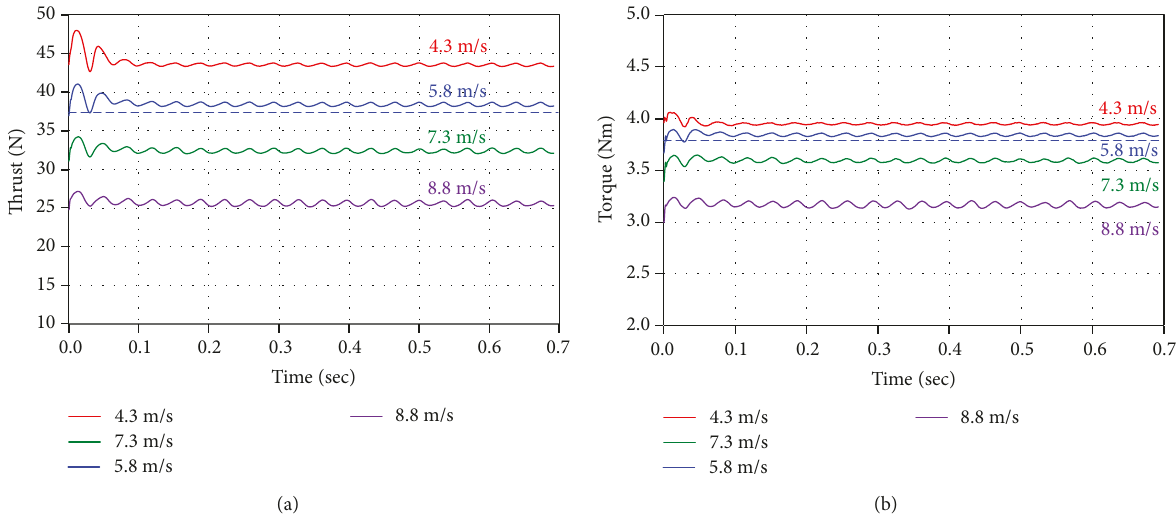
Figure 21: Comparison of CFD results with (a) design code and (b) wind tunnel